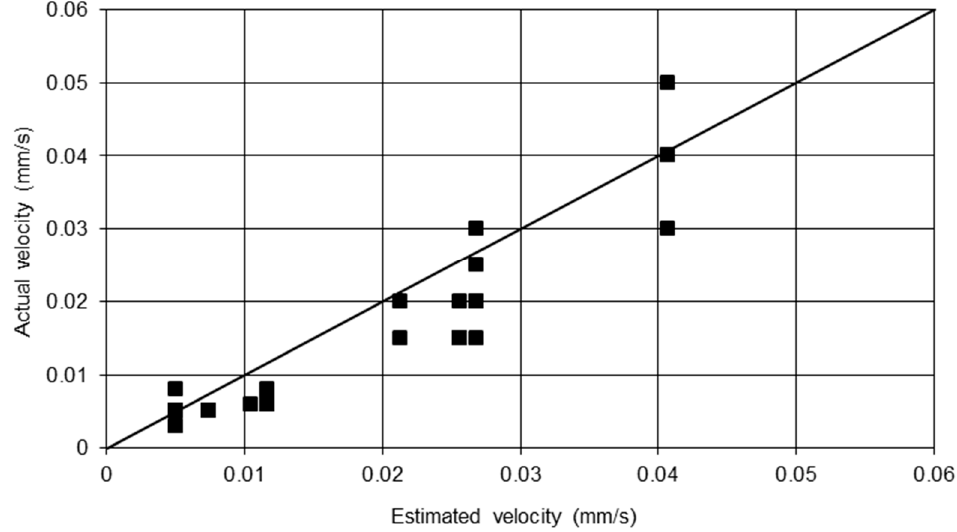
Figure 12. Correlation between actual velocities and velocities estimated by Equation (6).